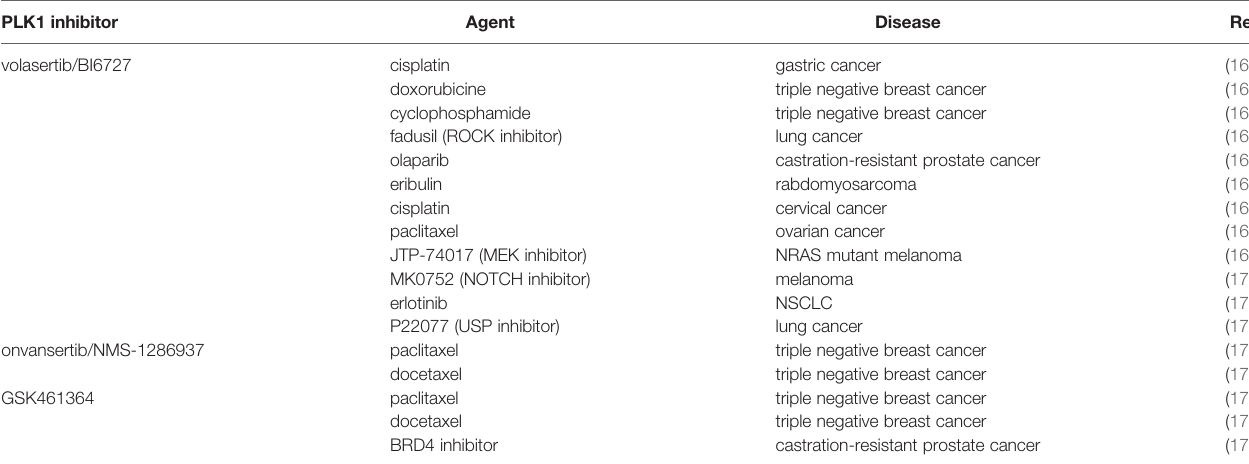
TABLE 2 | Combination strategies with PLK1 inhibitors: in vitro